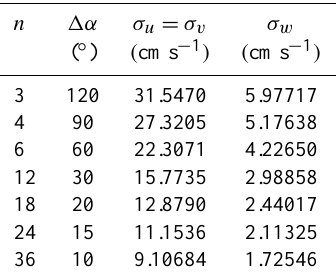
Table 2. Decrease of the uncertainties ( σ u ,σ v ,σ w ) in the 3-D wind vector component retrievals u,v and w with increasing number n of equidistant beam directions per VAD-scan. The values are cal- culated via Eq. (10) assuming a Doppler velocity uncertainty of σ r = 10cms − 1 for each beam direction. (cid:49)α indicates the azimuth